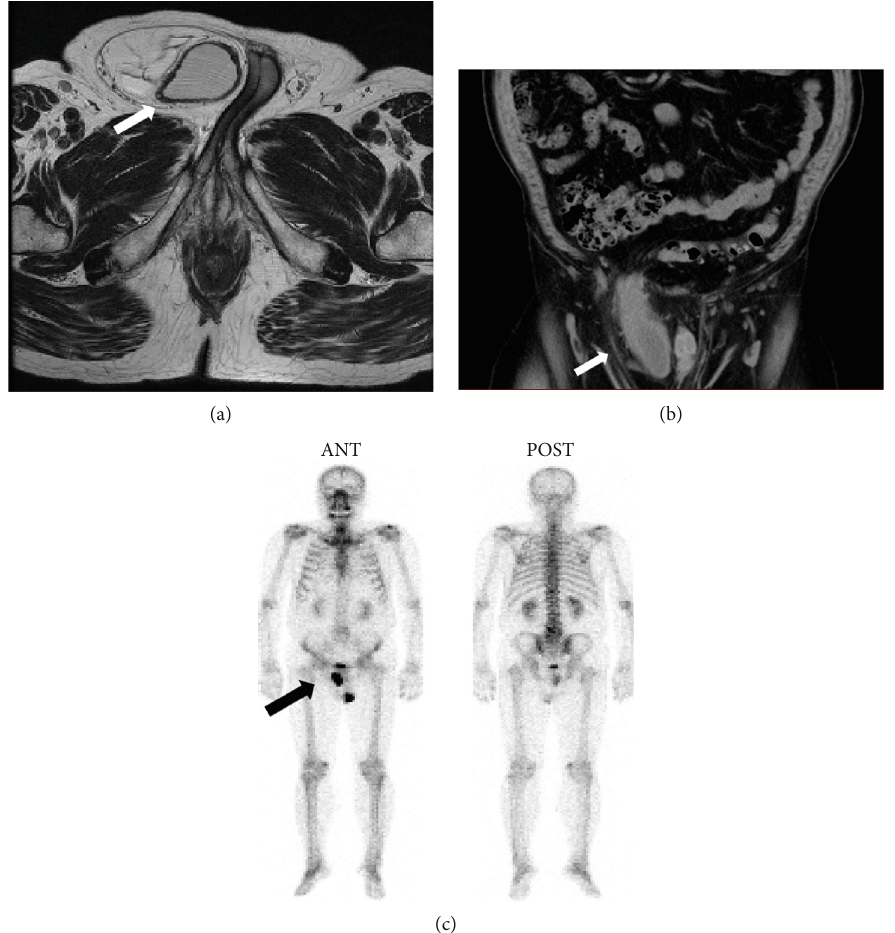
Figure 3: Images of case 2 showing the bladder in the right inguinal hernia. (a) Axial MRI image: the arrow indicates the IBH. (b) Coronal CT image: the arrow indicates the IBH. (c) BS image: the arrow indicates the IBH. BS: bone scintigraphy; MRI: magnetic resonance imaging; CT: computed tomography; IBH: inguinal bladder